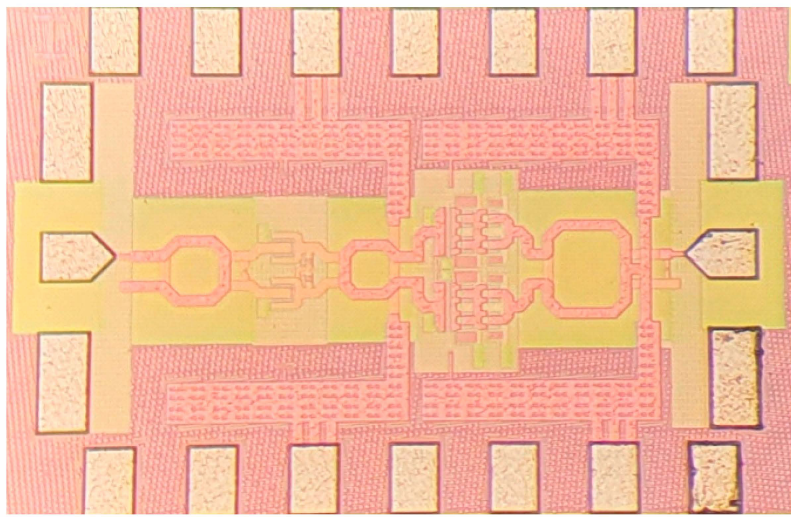
Figure 13. Chip photograph of the designed PA (core size: 0.725 × 0.500 mm 2